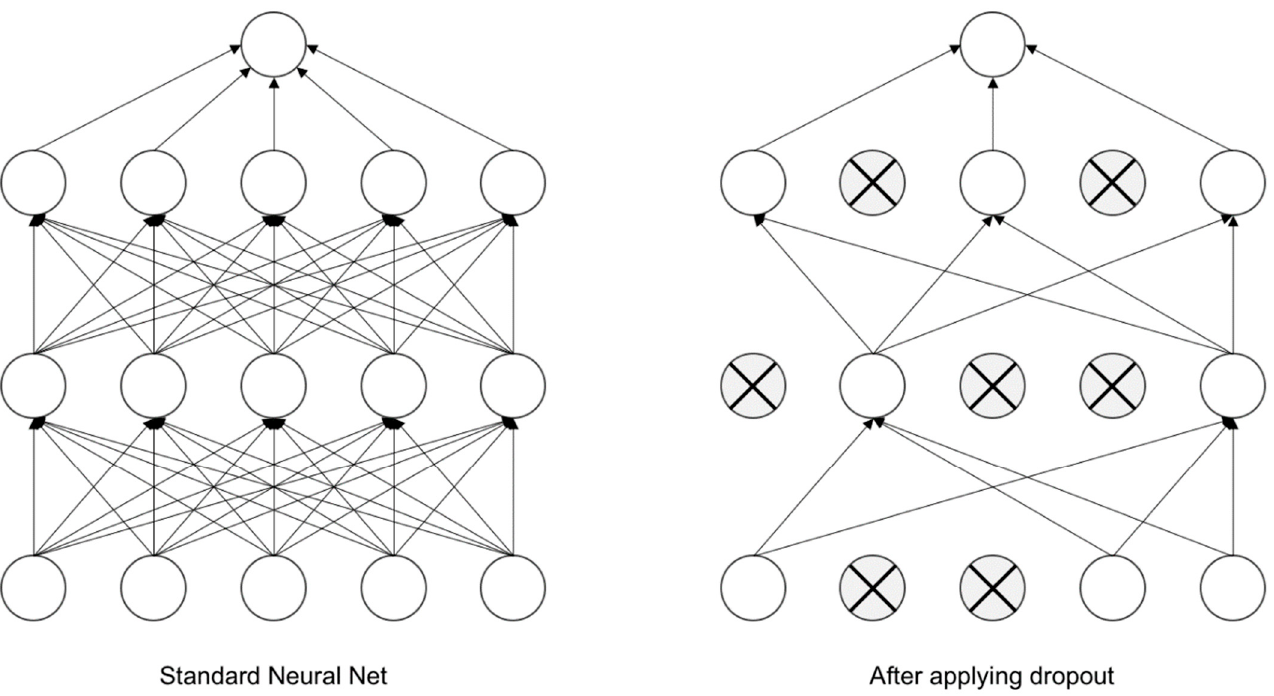
Figure 7. Effect on neurons after applying a dropout layer [33].